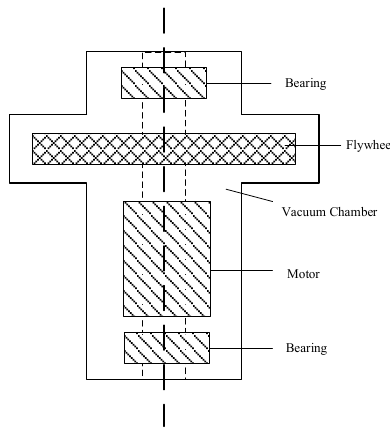
Fig. 3. FESS structure diagram.